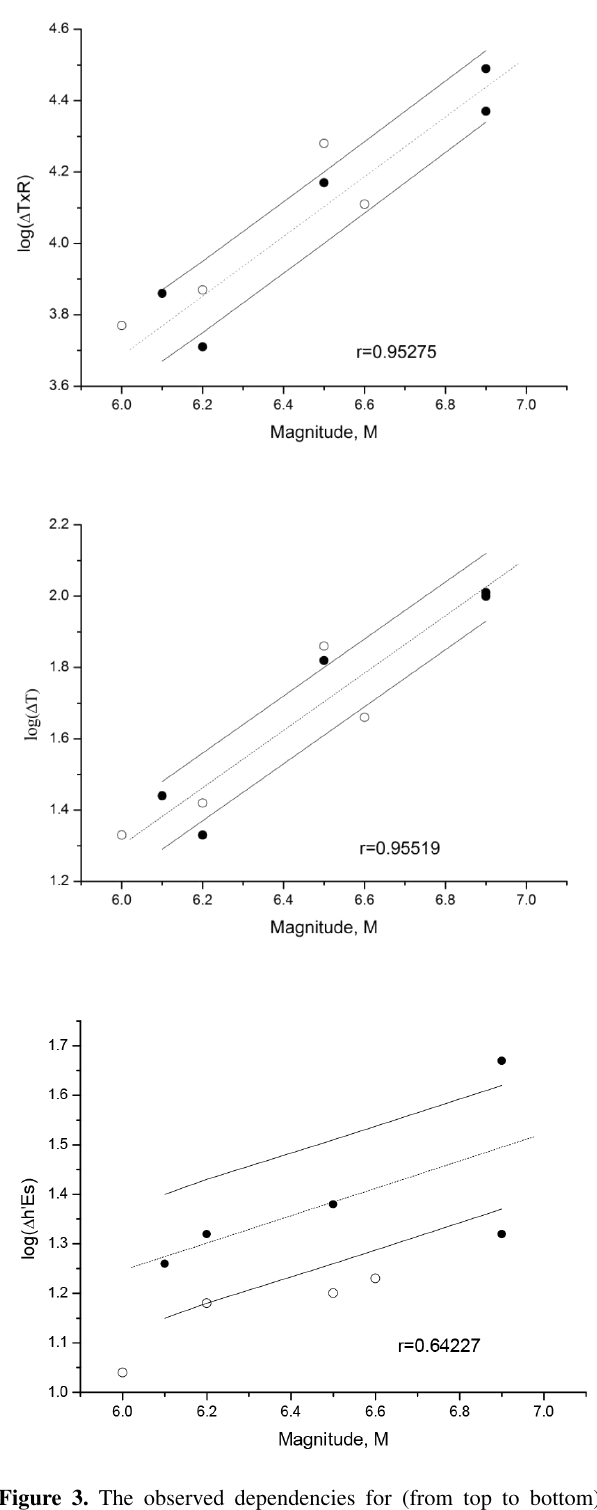
Figure 3. The observed dependencies for (from top to bottom) log ((cid:49)T × R) , log (cid:49)T and log ((cid:49) h (cid:48) Es) on the EQ magnitude. Cor- relation coefficients ( r ) of the points from the regression line are given. Each dash line is the best linear fit, while the continuous lines are those corresponding to ± 1 standard deviation